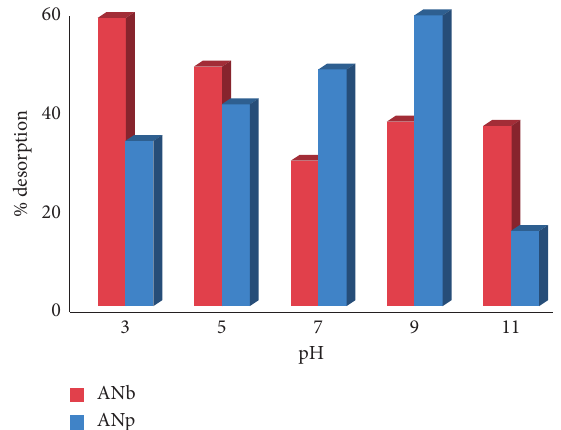
Figure 16: Desorbed yields of MR dye from raw (ANb) and pu- rified (ANp)